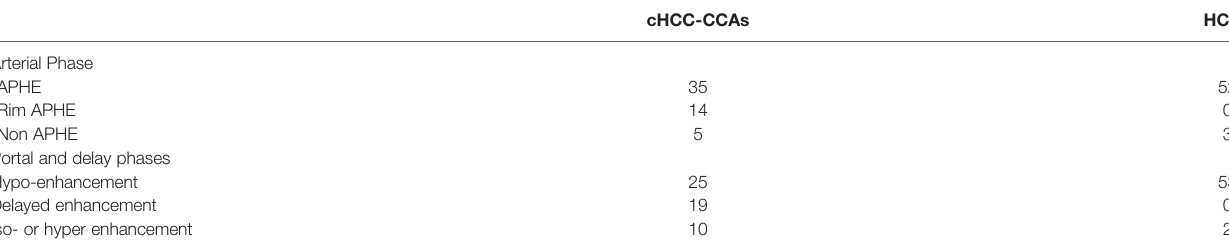
TABLE 3 | Contrast enhancement patterns of cHCC-CCAs and HCCs on CT/MRI.